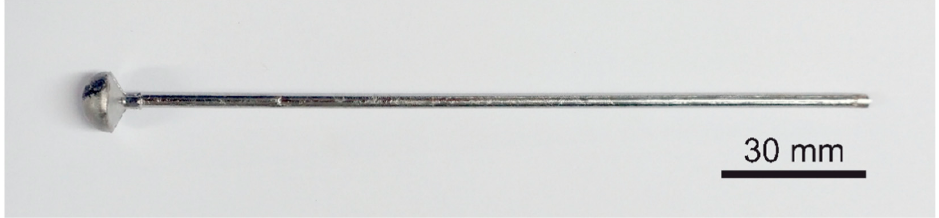
Figure 2. The rod obtained by the method of suction